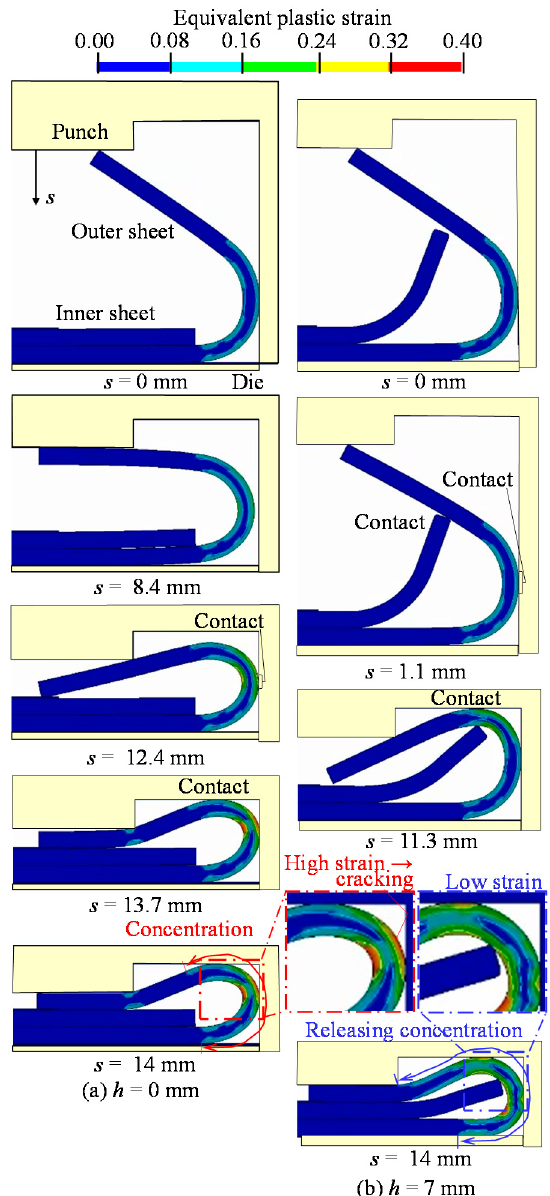
Figure 6. Deforming behaviors of sheets in joining stage for h = 0 mm and h = 7 mm in calculation.